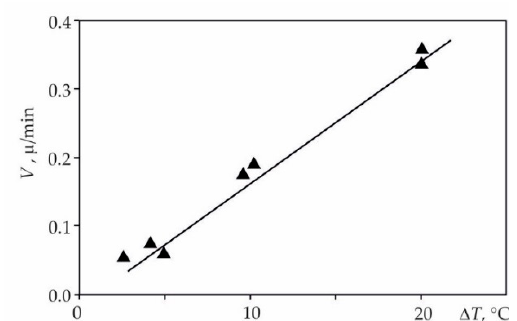
Figure 7. Normal growth rate vs. relative supercooling for Yb(10 at.%):YAB epitaxial layers from a 17–83 wt.% (91.0 wt% K 2 Mo 3 O 10 − 8.0 wt% B 2 O 3 − 1.0 wt% Y 2 O 3 ) solvent [42]. Reprinted from the